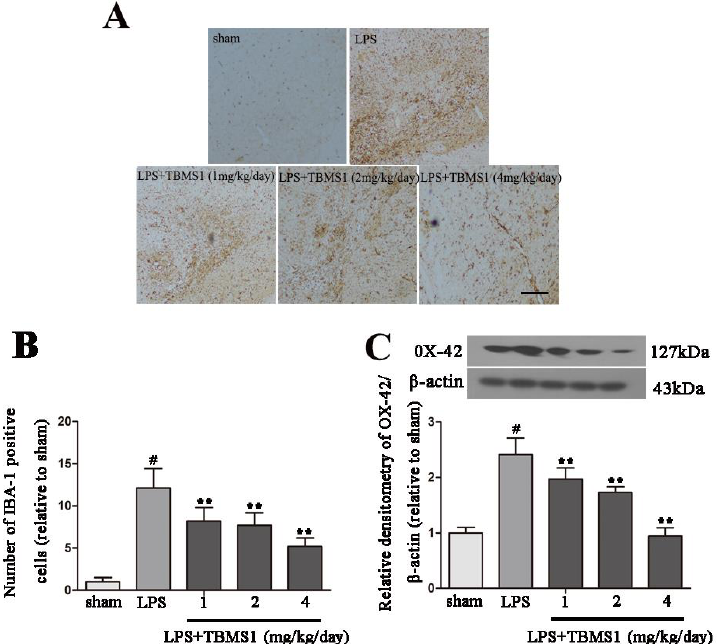
Figure 3. Effect of TBMS1 on microglial activation. The PD rat models were anesthetized and sacrificed to obtain the midbrain after 4 weeks’ TBMS1 treatment. ( A ) Calcium-binding adaptor molecule-1 (IBA-1)-positive cells in 100 × Fluorescence microscope via immunohistochemistry, the scale bar represents 200 μm ( n = 5 per group); ( B ) IBA-1-positive cells’ number was counted by